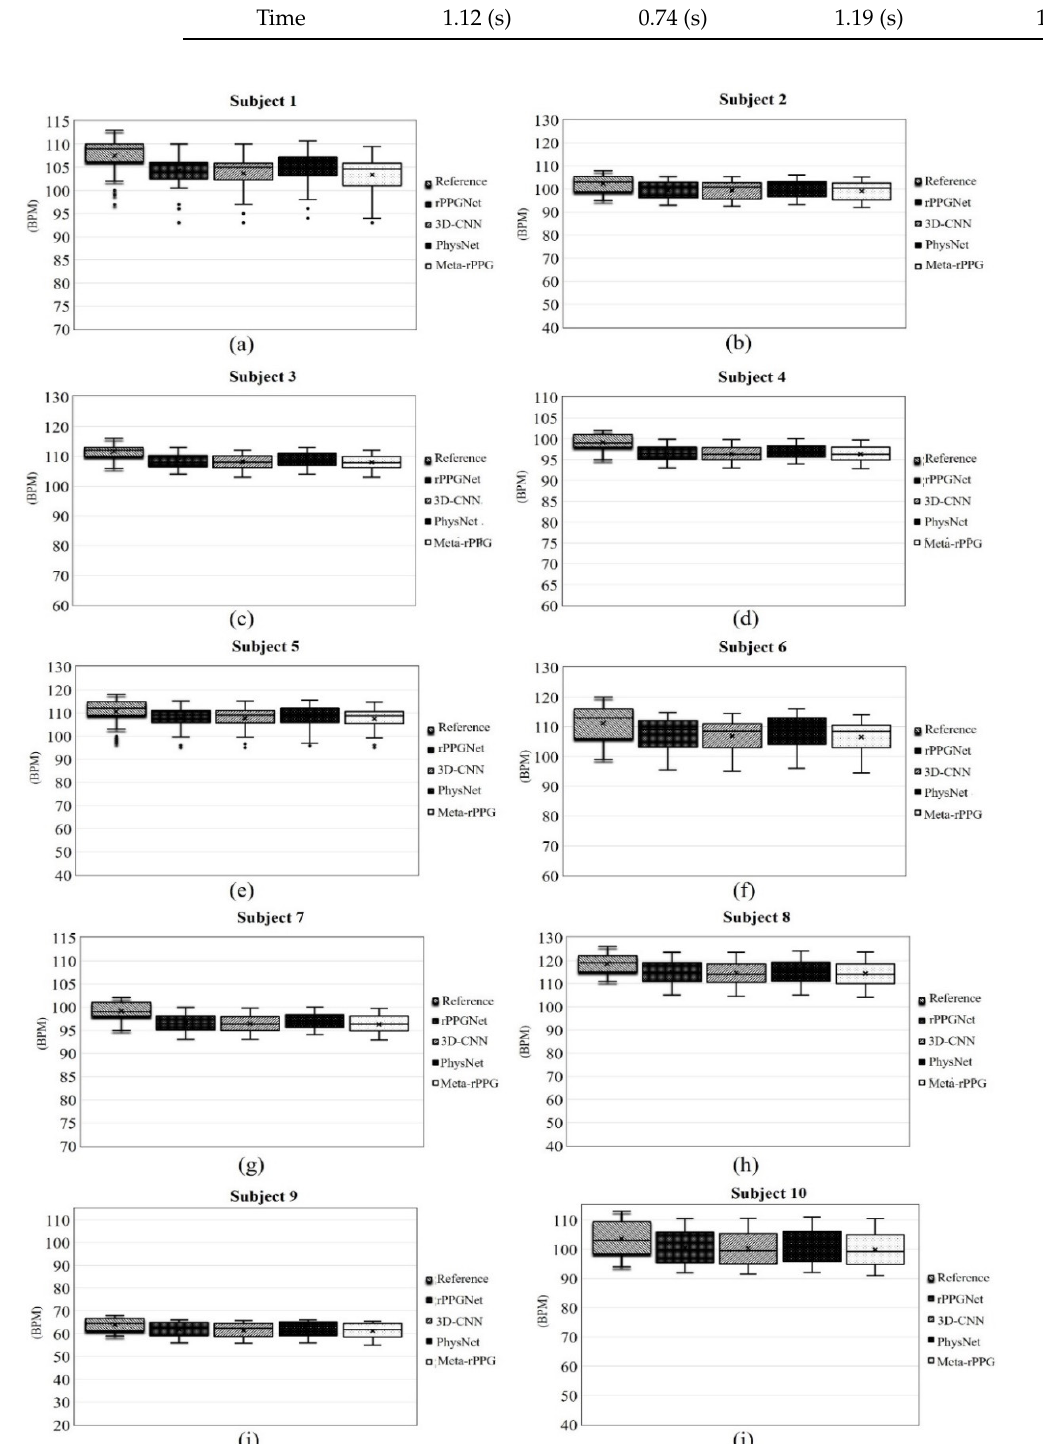
Figure 15. Heart rate bar charts of all the subjects in the test set for the four compared deep learning methods. Each part of figure ( a – j ) corresponds to one subject in the test set. The vertical axis indicates the heart rate in bpm. The mean and the standard deviation of each subject are specified in separate bar charts. In each chart, the first bar from the left indicates the reference for a subject.